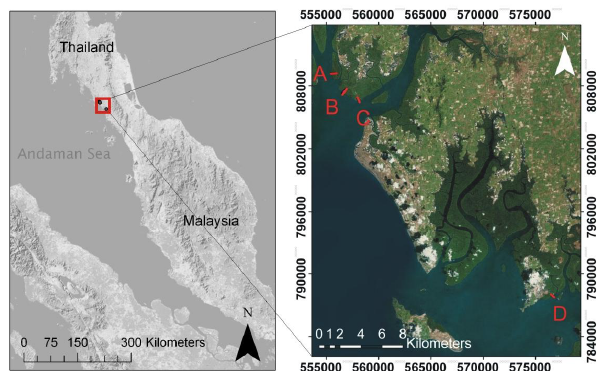
Fig. 1. Field sites in SW Thailand in the province of Trang. Four transects were laid out from the tidal flat towards the back of the mangrove forest (A–D) to measure surface sediment mixing. Re- gional map and aerial photograph from ArcGIS basemaps/Bing. Singapore is located at the southern tip of the Malay Peninsula.